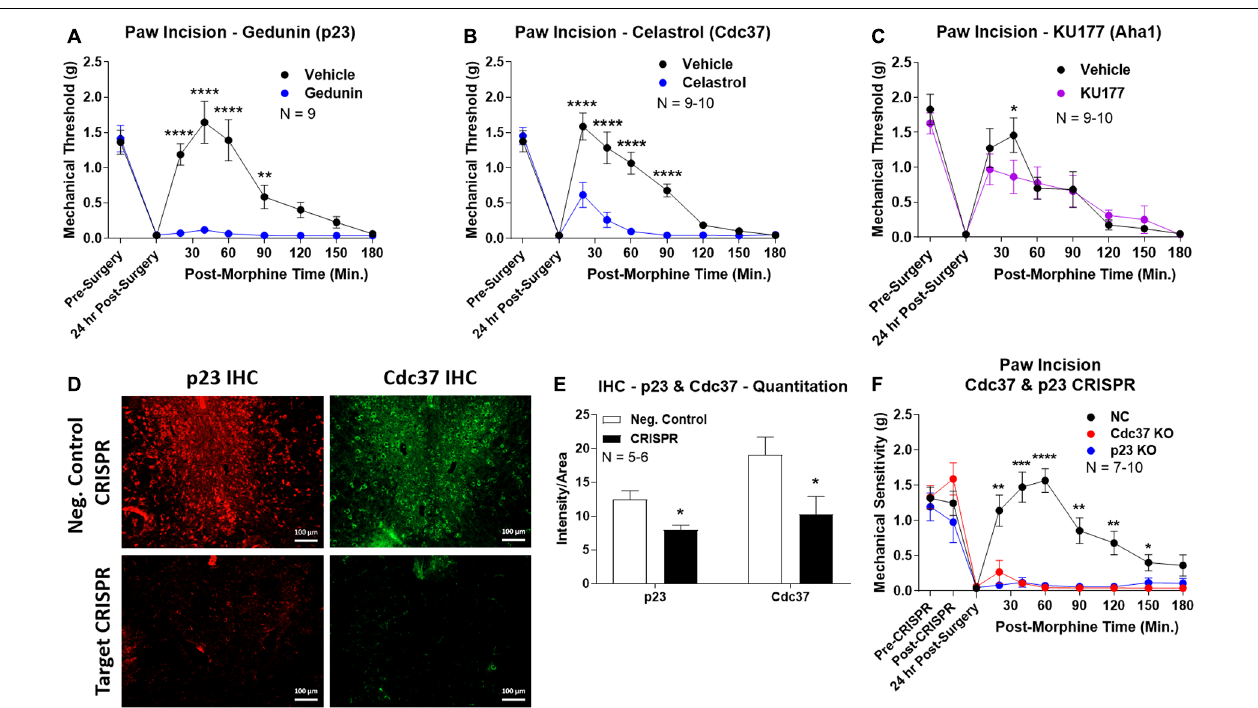
FIGURE 4 | Identification of the co-chaperones p23 and Cdc37 as promoters of opioid anti-nociception in the brain. Male CD-1 mice used for all experiments, data reported as the mean ± SEM, with sample sizes of mice/group noted in each graph. (A–C) Ten nanomoles of Gedunin (p23, A ), 10 nmol of Celastrol (Cdc37, B ), or 0.1 nmol of KU177 (Aha1, C ) or Vehicle control injected icv concurrently with paw incision surgery with a 24 h recovery, followed by 3.2 mg/kg morphine sc . Experiments performed with two technical replicates for each drug. ∗ , ∗∗ , ∗∗∗∗ p < 0.05, 0.01, 0.0001 vs. same time point inhibitor treatment group by two-way ANOVA with Fisher’s Least Significant Difference post hoc test. (D) p23, Cdc37, or Negative Control CRISPR-treated mice with icv delivery of constructs analyzed by IHC for target knockdown on day 10. Representative images shown from the PRN. Both targets (p23 – red, Cdc37 – green) have a similar staining pattern to Hsp90 α , and both are clearly reduced by CRISPR treatment. (E) Data from (D) for all mice quantitated as described in the “Materials and Methods” section. All mice treated in one technical replicate, with staining and analysis of the resulting tissue performed in more than one technical replicate. ∗ p < 0.05 vs. same target Negative Control group by Unpaired 2-Tailed t -test. CRISPR treatment reduced p23 signal by 36.3% and Cdc37 by 46.0%. (F) CRISPR-treated mice had paw incision surgery performed on day 9, with injection of 3.2 mg/kg morphine sc on day 10. Performed in two technical replicates. ∗ , ∗∗ , ∗∗∗ , ∗∗∗∗ p < 0.05, 0.01, 0.001, 0.0001 vs. both same time point p23/Cdc37 CRISPR groups by two-way ANOVA with Fisher’s Least Significant Difference post hoc